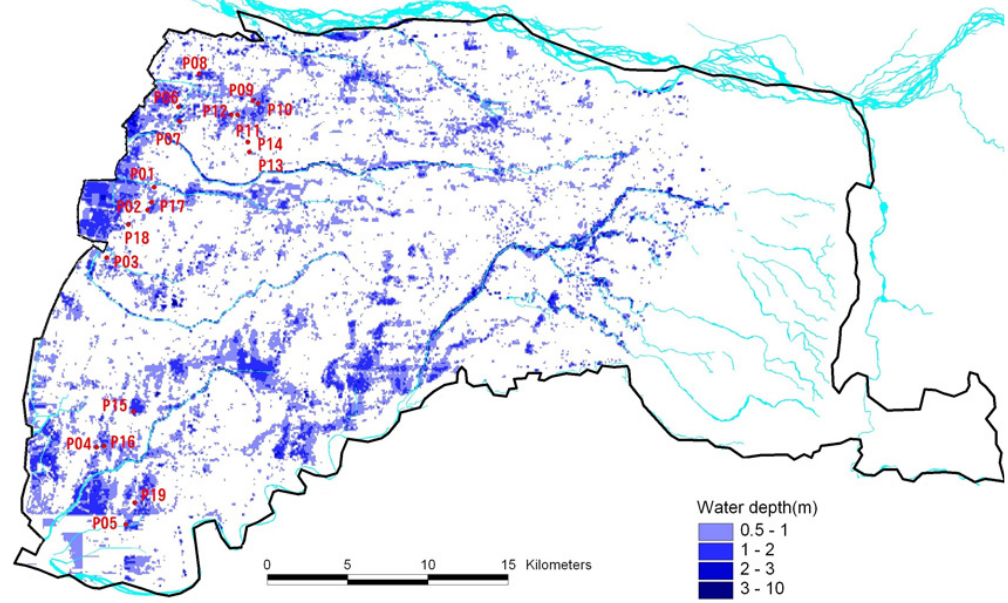
Fig. 6. Inundation map under the 24-h design rainfall event with a 10-yr return period with 19 representative inundation locations. Table 2. Information about the 13events selected from Yunlin inundation